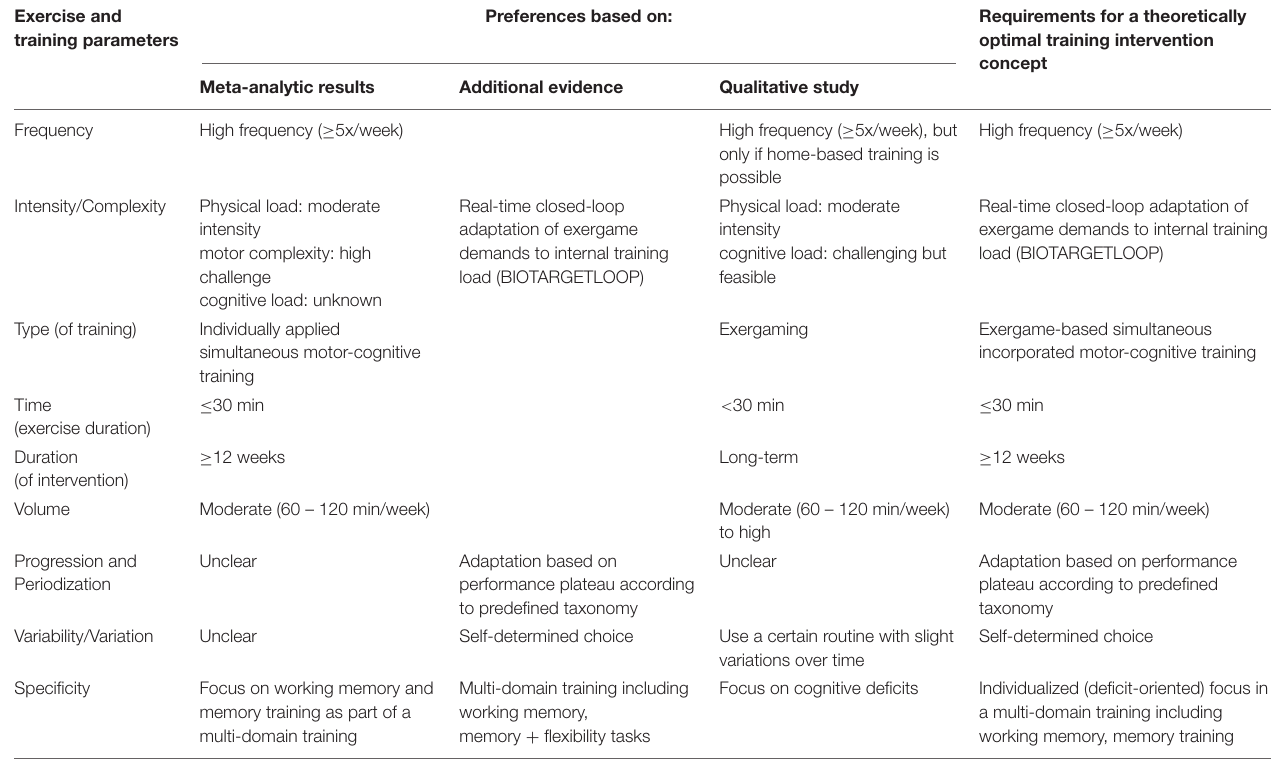
Preferences based